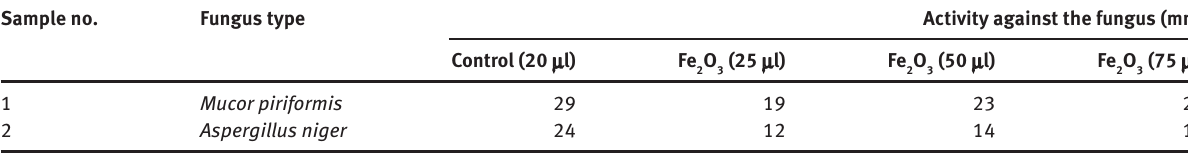
Values are represented as mean ± 1 (SD).